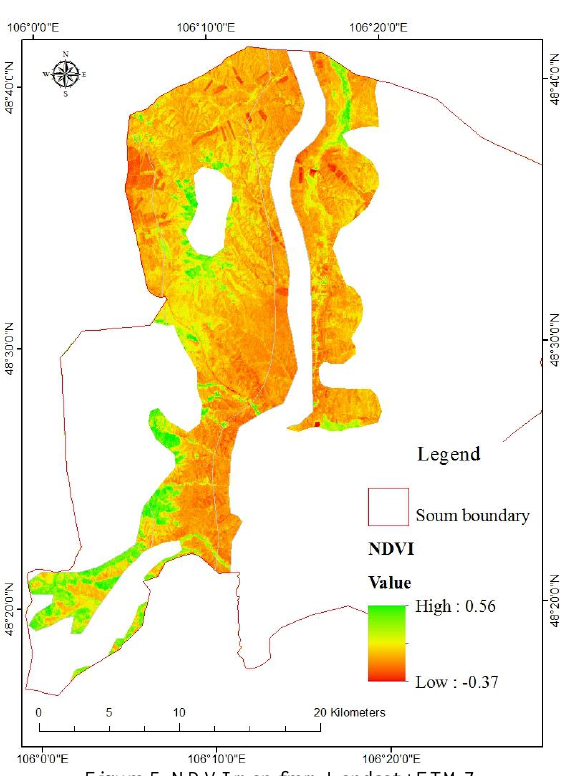
Figure 5. NDVI map from Landsat +ETM7